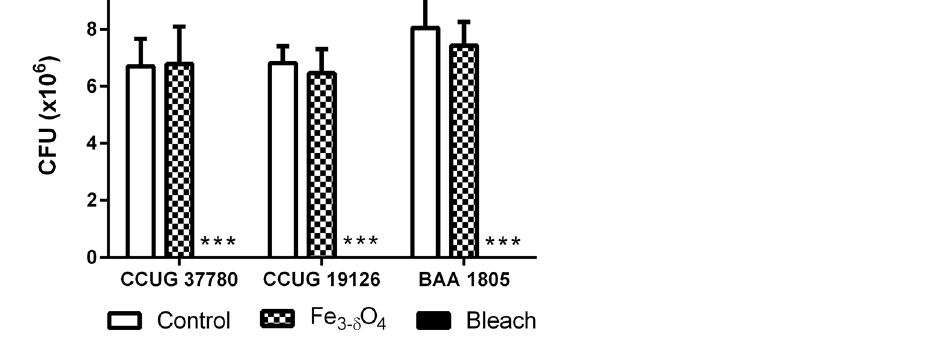
between those treated with 500 μ g/ml of Fe 3- δ O 4 nanoparticles and those treated with sodium hypochlorite, but CCUG 19126 was relevantly resistant to treatment with 50 μ g/mL of Fe 3- δ O 4 nanoparticles (Fig. 3A). To evaluate the bactericidal effect of Fe 3- δ O 4 nanoparticles on vegetative cells in different strains, three groups of vegetative cells—CCUG 37780, CCUG 19126, and BAA-1805—were first treated for 20 minutes with 500 μ g/ mL of Fe 3- δ O 4 nanoparticles, spread on BHIS agar plates, and their CFUs were counted. The growth behavior of the Fe 3- δ O 4 -treated vegetative cells was not significantly different from that of the negative control groups; how- ever, almost all the vegetative cells treated with 3% sodium hypochlorite died (Fig. 4). Treatment with Fe 3- δ O 4 nanoparticles did not damage C . difficile vegetative cells.